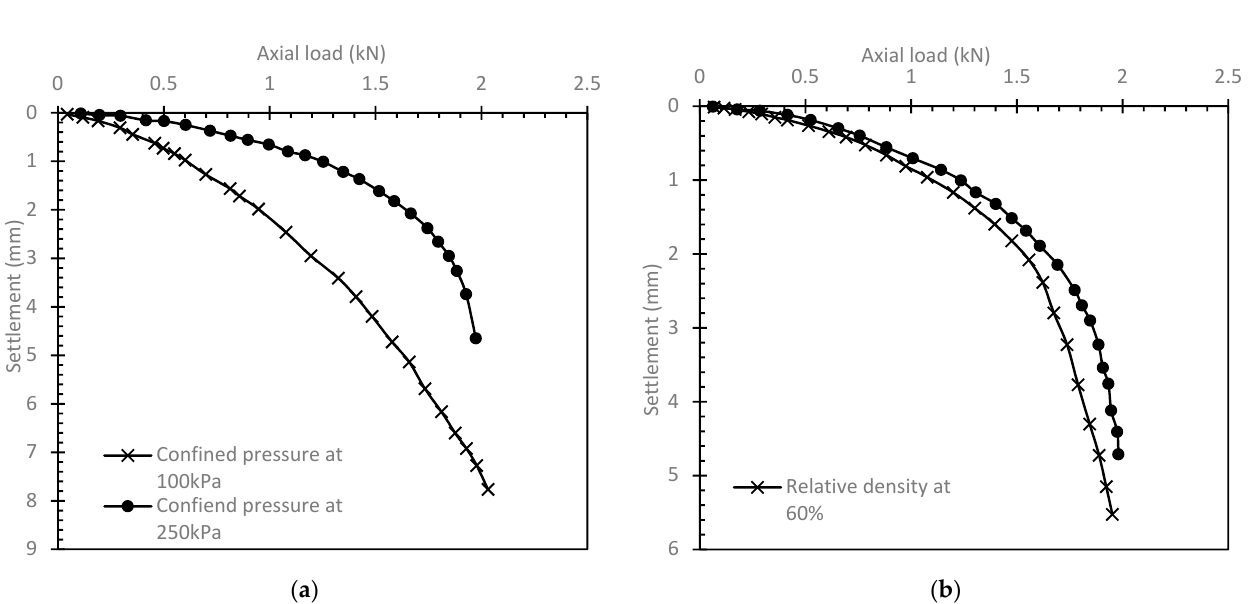
Figure 8. Effect of surface roughness under an axial load ( a ) and effect of loading rate on CFRP piles under an axial load ( b ).